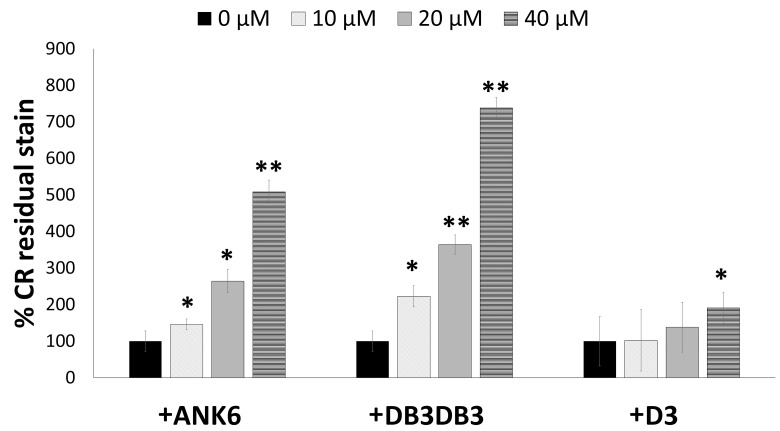
D-peptides reduce curli production in S. typhimurium biofilm.Quantification of the effect of D-peptides on curli fibril formation in the bacteria. Shown are the levels of measured residual CR in the agar following the removal of the biofilm colony of the S. typhimurium MAE150 cellulose-deficient mutant. Control colonies that were not exposed to the D-peptides were assigned 100% CR residual stain remaining in the agar. A higher percentage of residual CR stain indicates less CR adsorption by the colony and hence, reduced curli fibril formation. Error bars represent standard deviations. * p<0.05 and ** p<0.005 compared to control (no inhibitor added). CR plates from one of the experiments are shown in S15B Fig.